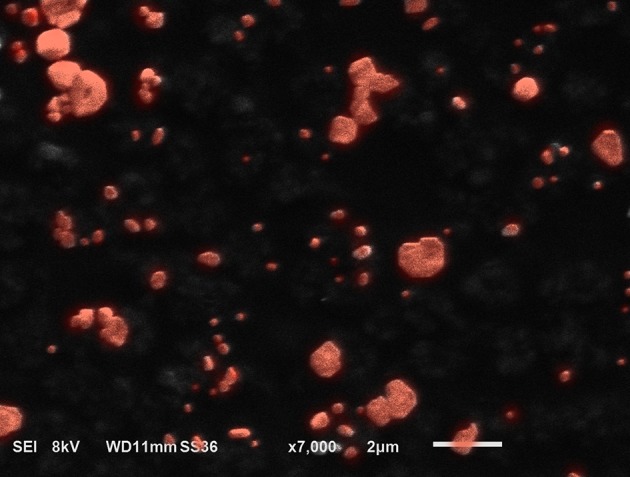
SEM image from microparticles developed from MAB. The particles are submicron to 2 microns in size.